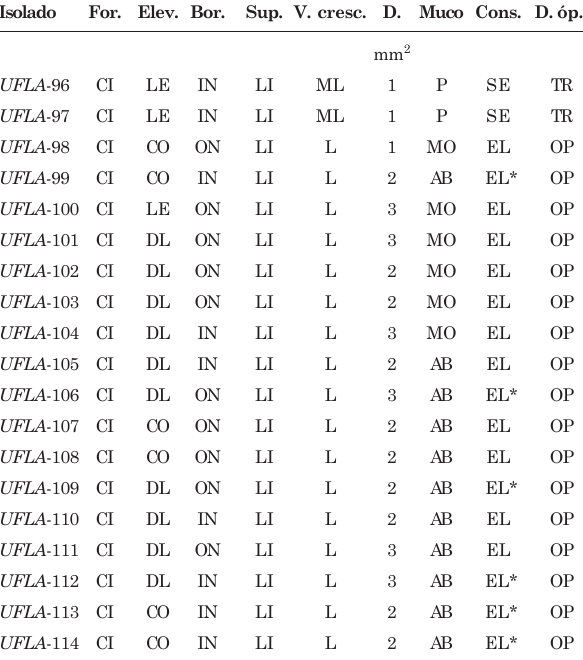
borda (Bor.), superfície (Sup.), velocidade de crescimento (V.cresc.), diâmetro (D.), produção de muco (Muco), consistência (Cons.) e detalhes ópticos (D.